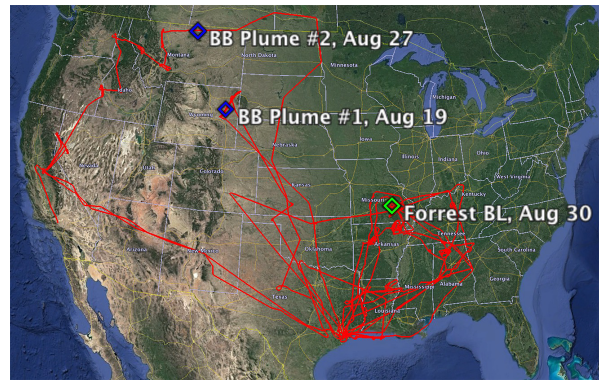
Figure 3. Flight paths of the 10 SEAC 4 RS flights from which data are used in this paper. Additionally, three specific case studies are called out with diamonds. The case studies include two biomass- burning-dominated aerosols (blue) as well as measurements made in the boundary layer of a forested region in southeastern Missouri